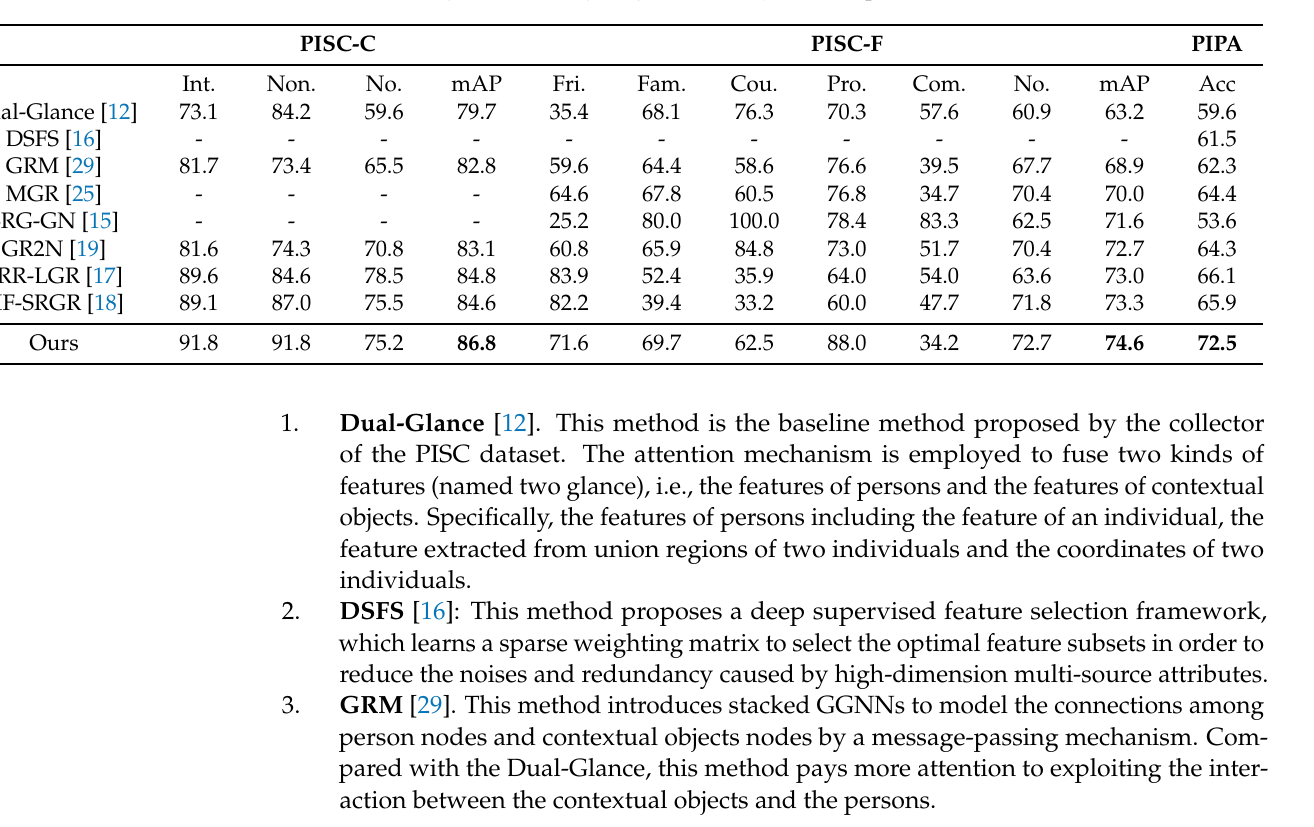
Table 3. The comparison results (per-class recall (in %) and the mAP over all classes (in %) for PISC and Acc (in %) for PIPA) of our MT-SRR model with the state-of-the-art methods on PISC-C, PISC-F and PIPA datasets. Best results are highlighted in bold face. (Int.: ‘ intimate ’, Non.: ‘ non-intimate ’, No.: ‘ no relation ’, Fri.: ‘ friend ’, Fam.: ‘ family ’, Cou.: ‘ couple ’, Pro.: ‘professional’, Com.: ‘ commercial